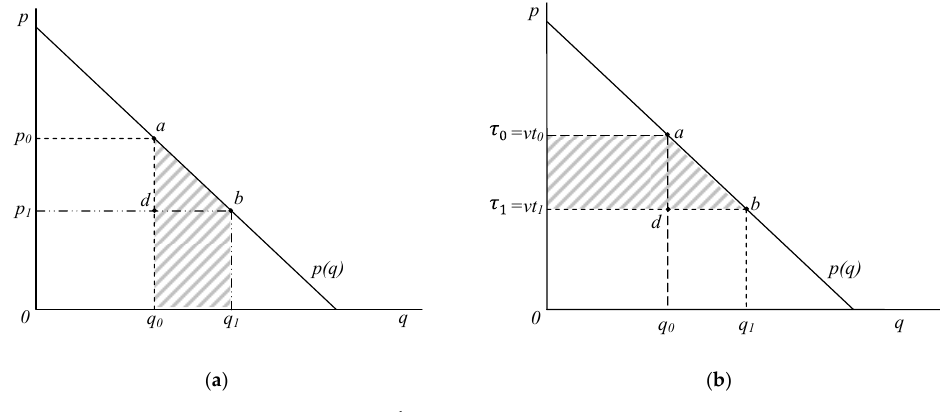
(𝑔 (cid:3047)(cid:2868) − 𝑔 (cid:3047)(cid:2869) )(𝑞 (cid:3047)(cid:2868) + 𝑞 (cid:3047)(cid:2869) ) , with 𝑔 = 𝑝 + 𝜏 and 𝜏 = 𝑉 · 𝑡 , where V Figure 4. Consumer surplus ∆ CS t = 1 − g + q ( g t )( q t ) , with g = p + τ and τ = V · t , where t 1 t 1 0 0 2 (cid:2870) − p + q ( p t )( q t ) ; ( b ) time saving: t 1 t 1 0 0 2